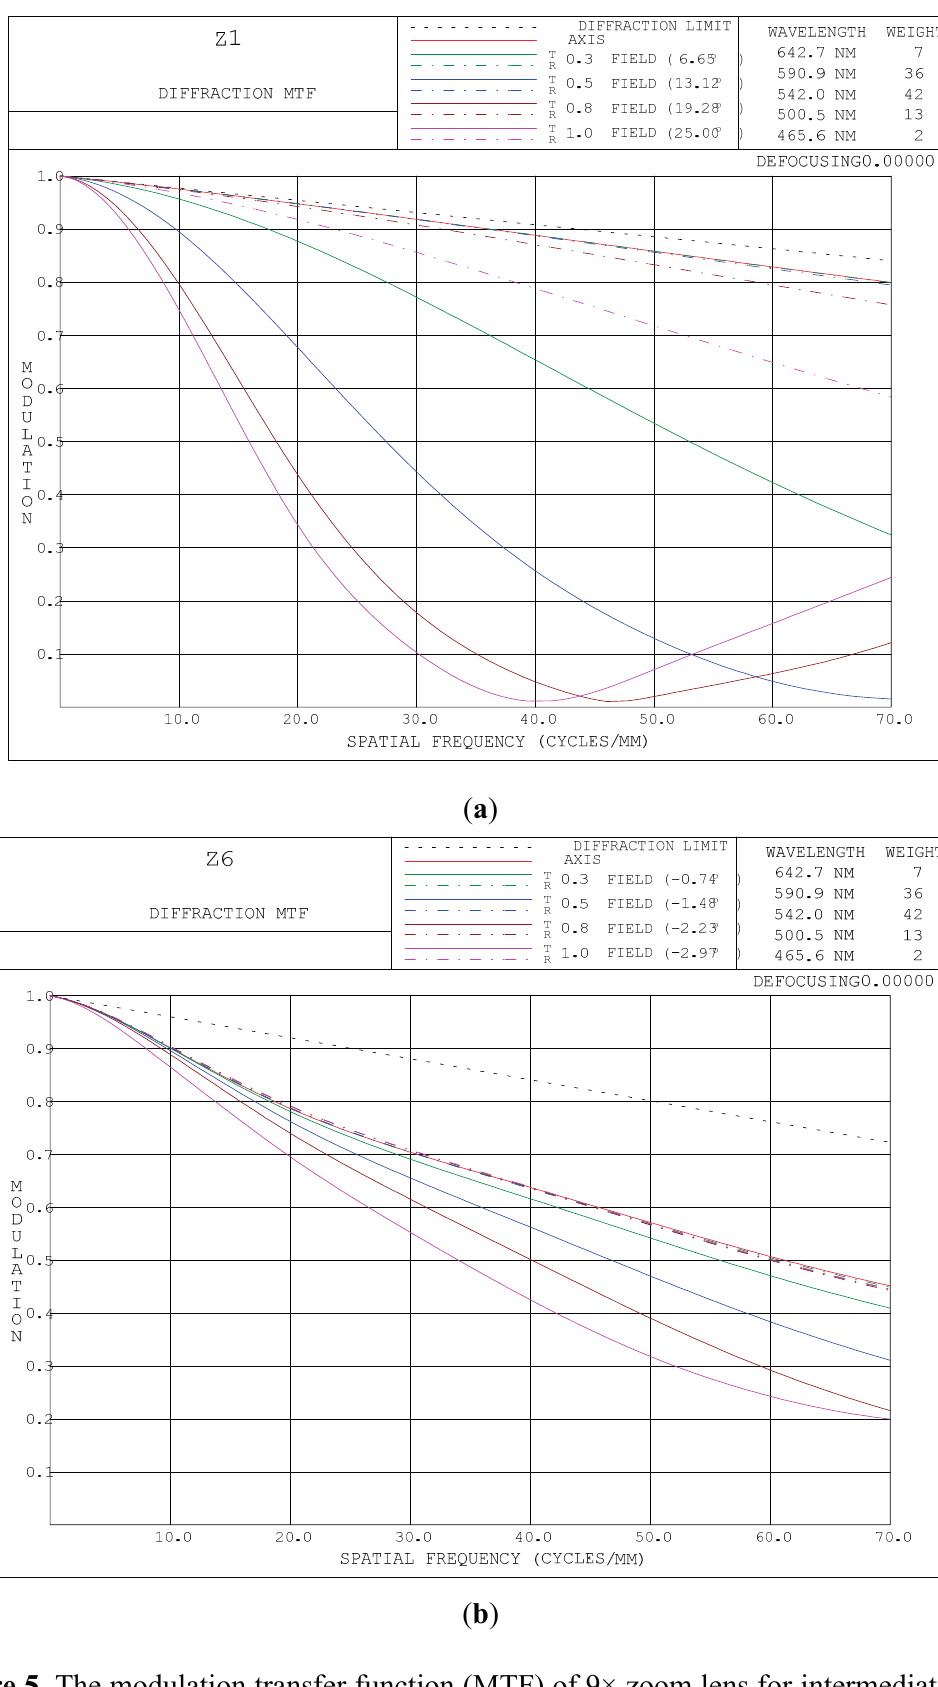
Figure 5. The modulation transfer function (MTF) of 9× zoom lens for intermediate optics design ( a ) 7.068 mm_F/#3.2 (Zoom 1); ( b ) 63.612 mm_F/#5.6 (Zoom